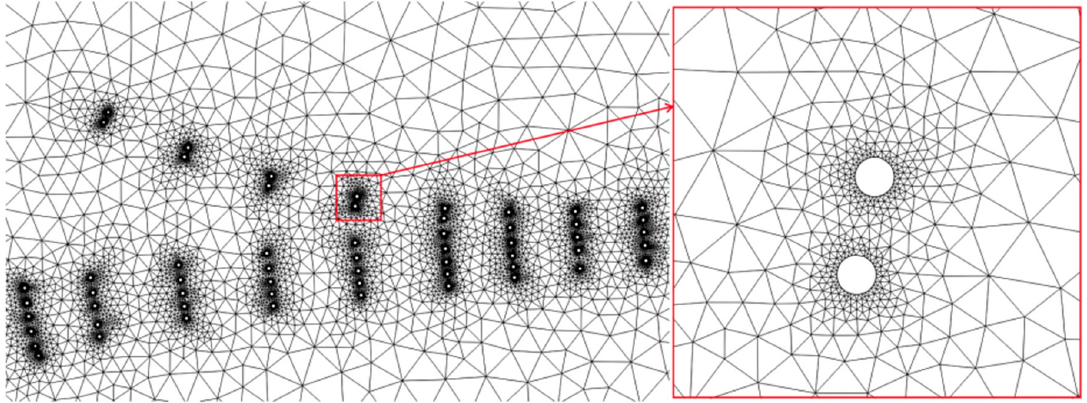
Figure 2. Simulation mesh near Fengxian Bridge (circles denote bridge piers).